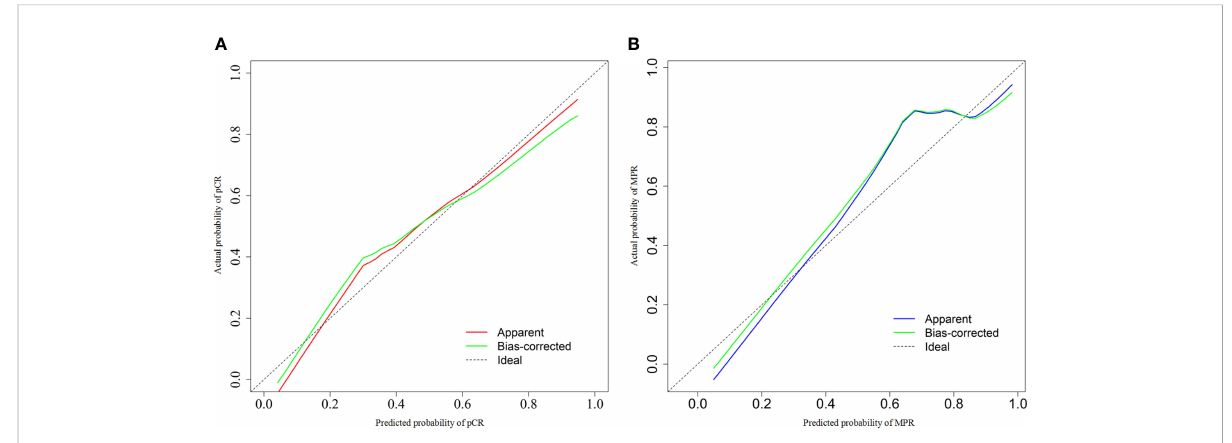
FIGURE 5 Calibration curves of predictive model. (A) For pathological complete response model; (B) for major pathologic response model. AUC, area under